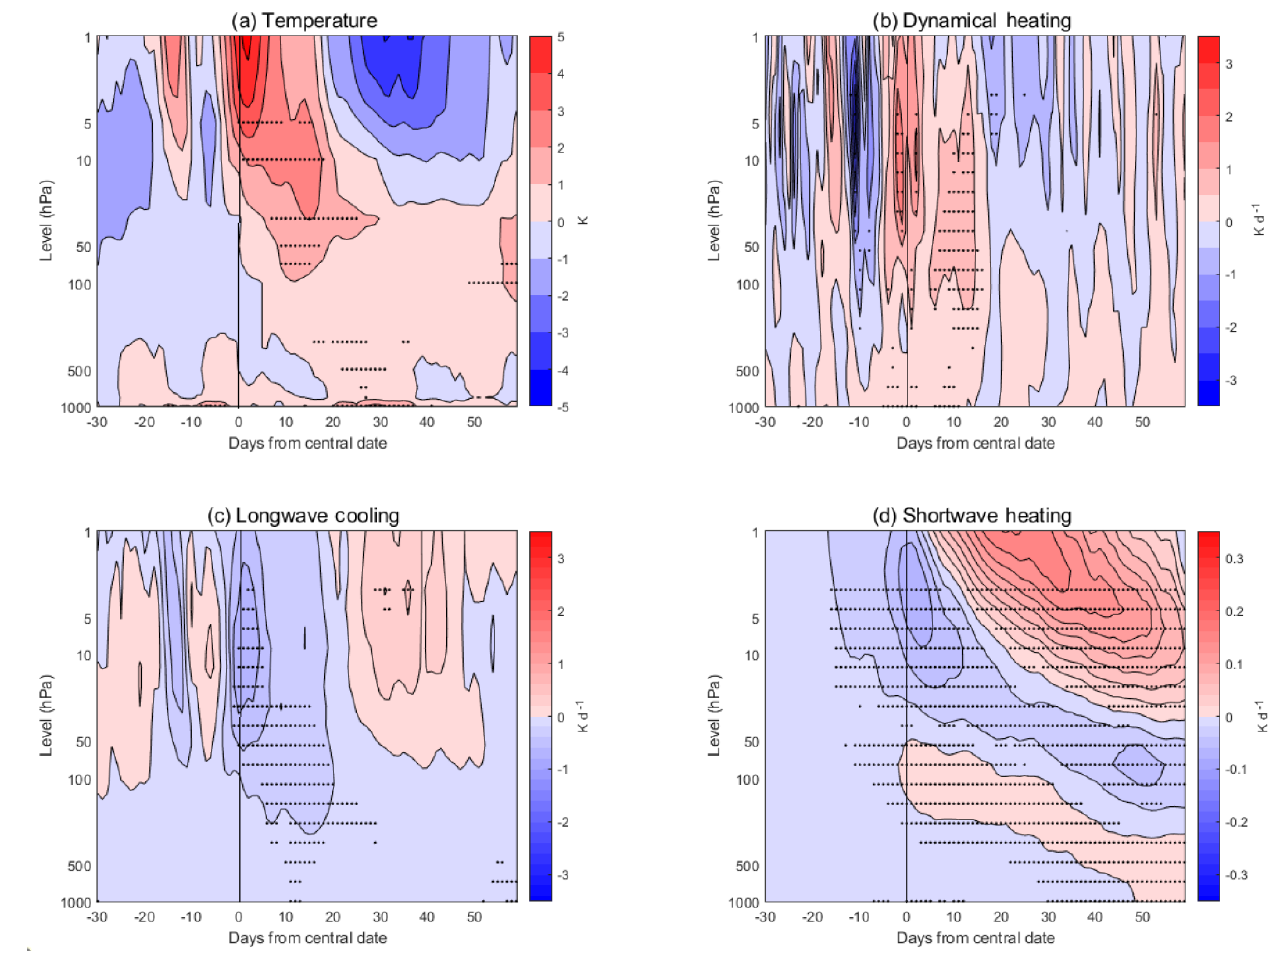
Figure 5. CHEM-NOCHEM differences in the temperature and heating anomalies over 60–90 ◦ N from − 30 to + 60d around the DJF SSW central dates. (a) Temperature anomalies. Contours are every 1K. (b) Dynamical heating anomalies. Contours are every 0.5Kd − 1 . (c) Longwave heating anomalies. Contours are every 0.25Kd − 1 . (d) Shortwave heating anomalies. Contours are every 0.02Kd − 1 . Stippling shows significance at the 95% level under a two-tailed t